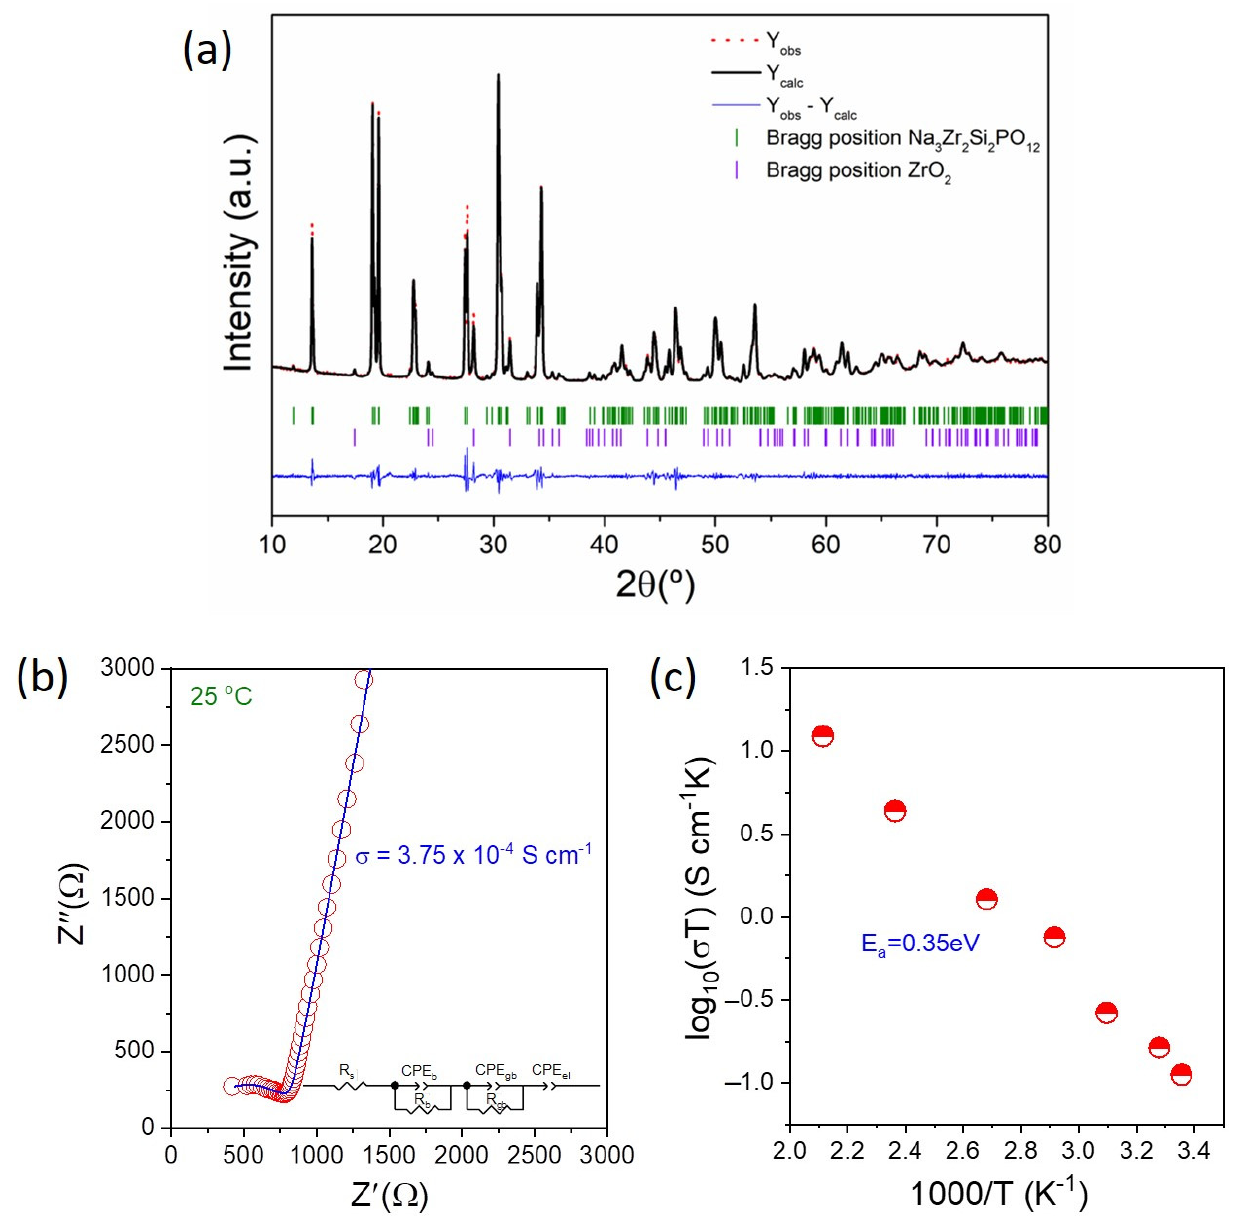
Figure 1. ( a ) Le Bail refinement of the PXRD patterns of Na 3 Zr 2 Si 2 PO 12 heated at 1230 ◦ C for 12 h. ( b ) Impedance plot of Au||NZSP||Au assessed at 25 ◦ C; ( c ) Arrhenius plot of NZSP measured in temperature range of 25–200 ◦